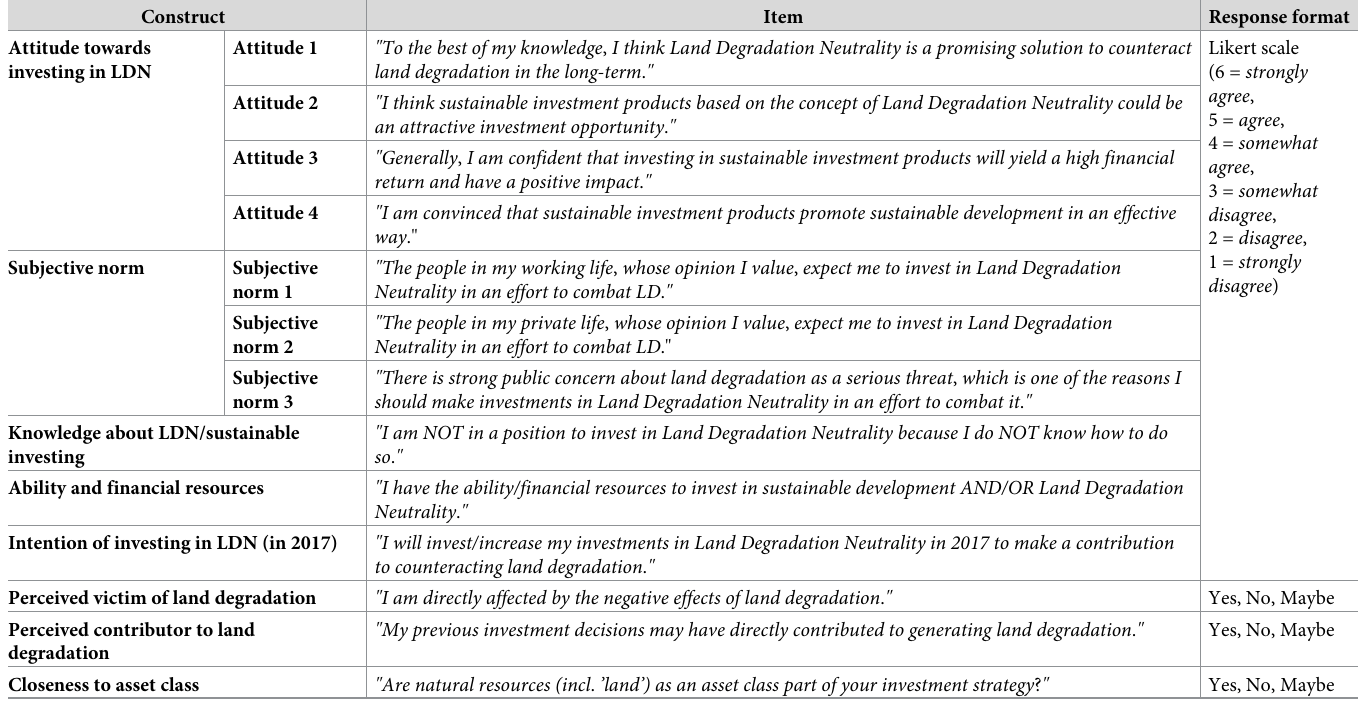
Table 1. Overview of items used for the intention to invest in LDN analysis. Construct